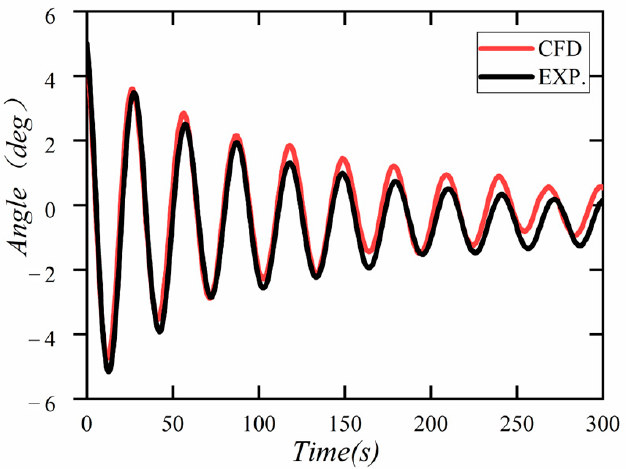
Figure 12. Pitch of the experimental and numerical model at a platform inclination of 5°. We measured and simulated the slamming pressure at K1 of different wave parameters. λ for different wave periods